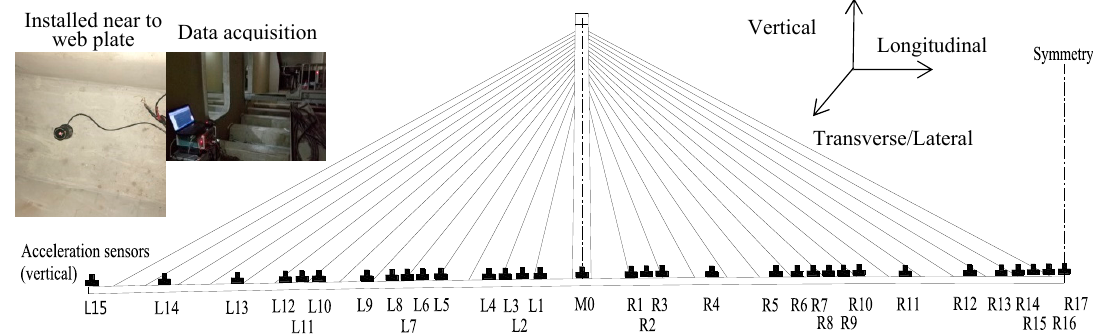
Figure 4. Arrangement of vertical acceleration sensors along the girder.